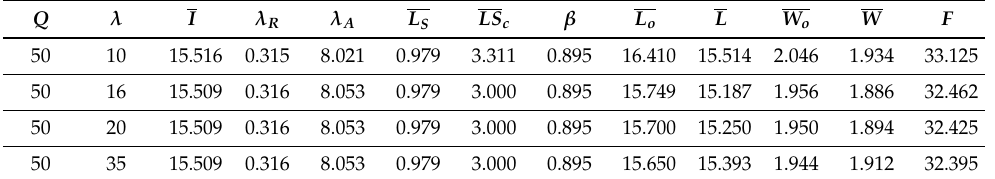
Table 9. The effect of µ on performance measures at Q =